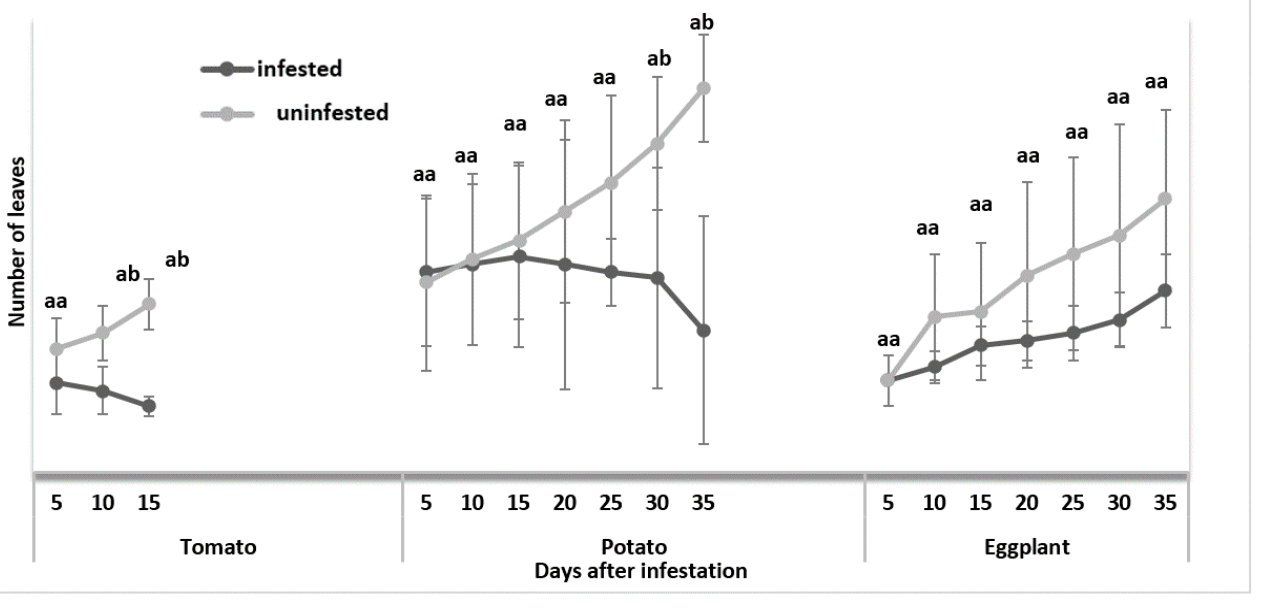
Figure 3. Comparison of the mean number of leaves found on uninfested and Tuta absoluta -infested plants. Means followed by different letters in the same bar column are significantly different at p < 0.05.